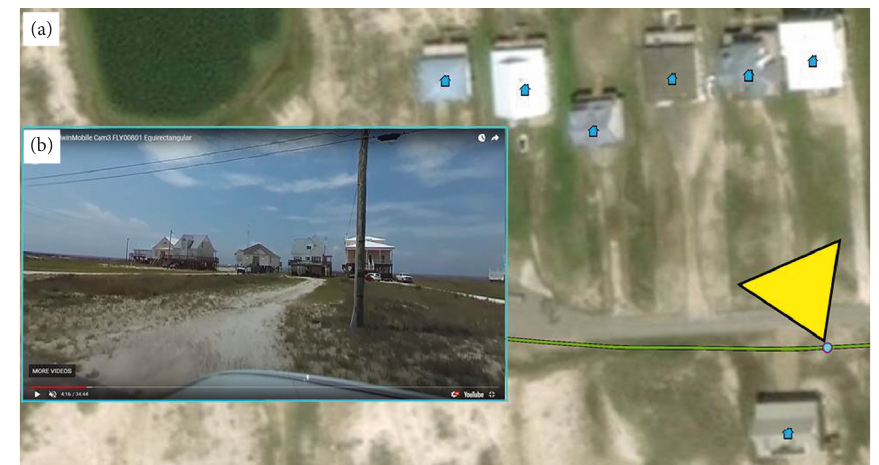
Figure 4: Geolocated vehicle-mounted 360 ° video visualization technique in the EEWV.